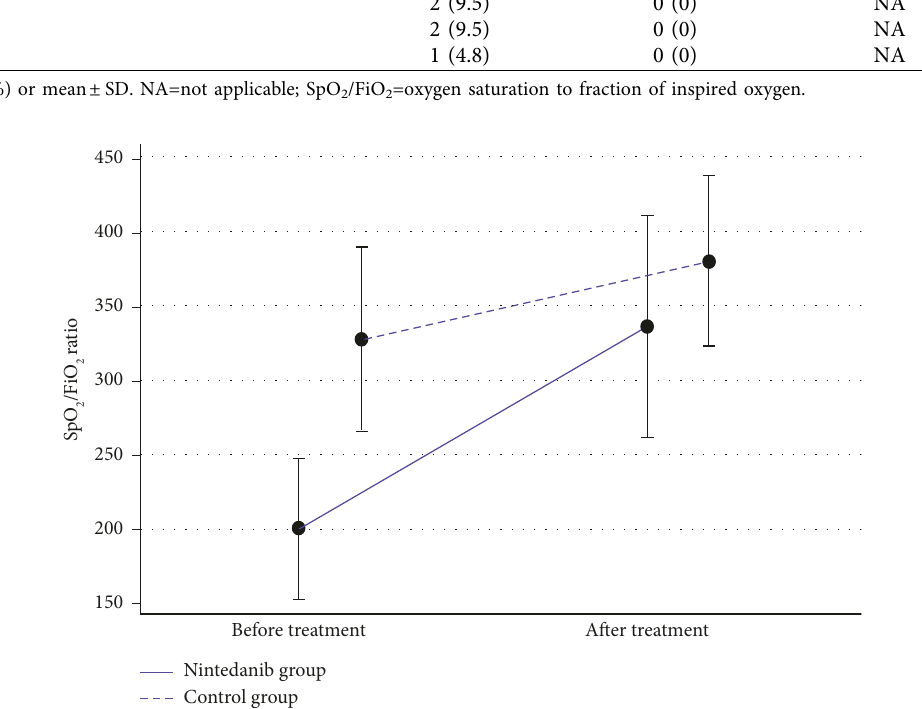
2 /FiO 2 ) difference between before and after